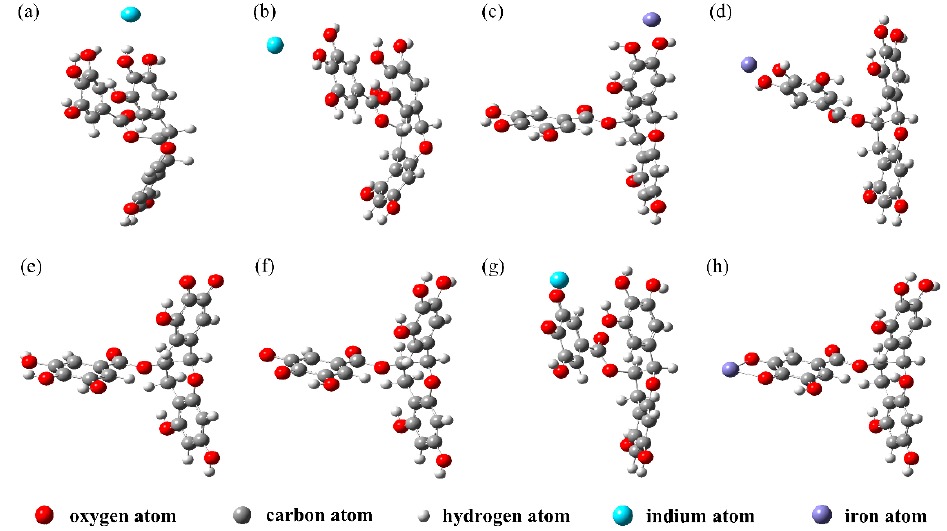
Figure 2. Structural models of EGCG–metal complexes, namely, ( a ) B-EGCG–In(III), ( b ) D-EGCG– In(III), ( c ) B-EGCG–Fe(III), and ( d ) D-EGCG–Fe(III), and deprotonated EGCG–metal complexes, namely, ( e ) B(-2H)-EGCG, ( f ) D(-2H)-EGCG, ( g ) D(-2H)-EGCG–In(III), and ( h ) D(-2H)-EGCG– Fe(III).